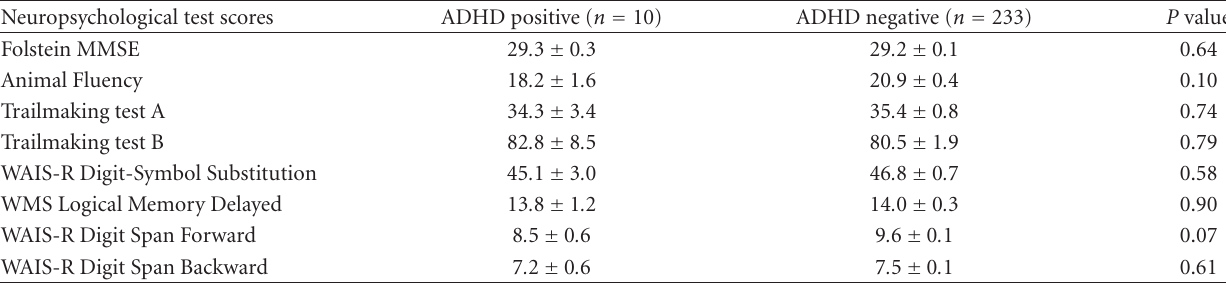
Table 3: Mean neuropsychological test scores ( ± SEM) in cognitively intact subjects only, adjusted for age, sex, and education in presumptive positive and negative childhood ADHD subjects as determined by Wender-Utah Rating Scale score.